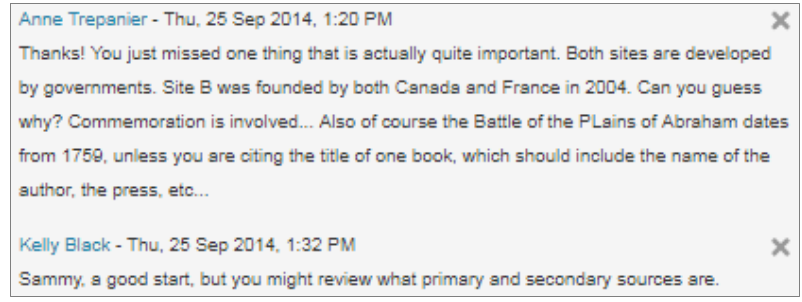
Figure 2. Open feedback for assignment